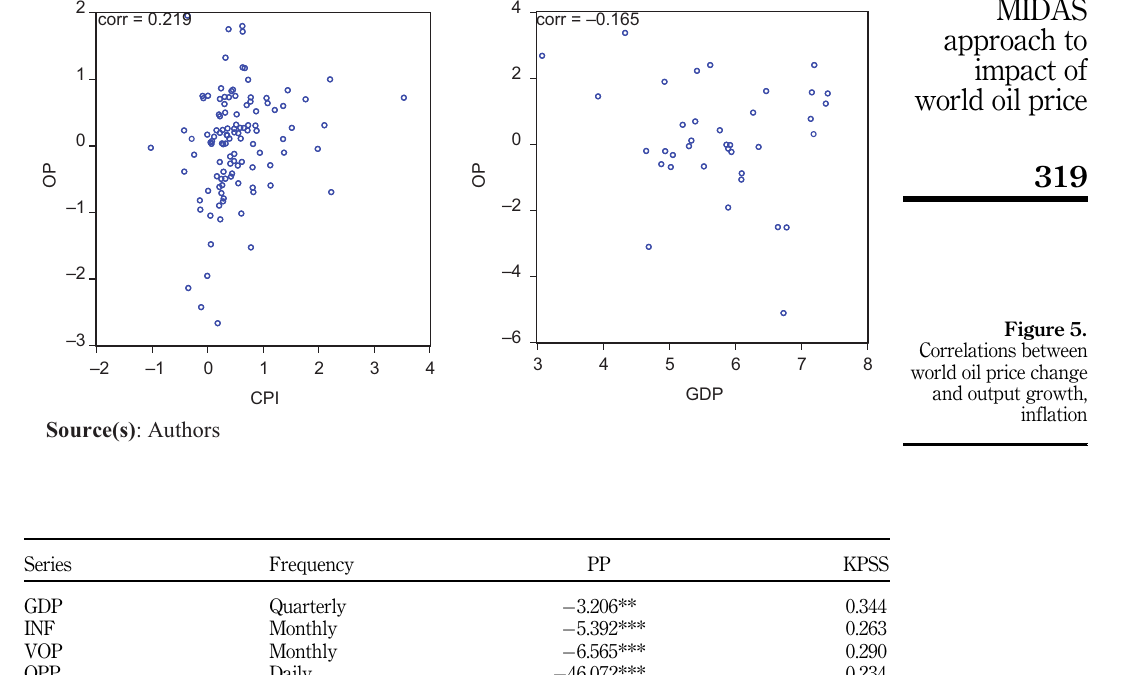
Table 2. Results of unit root test